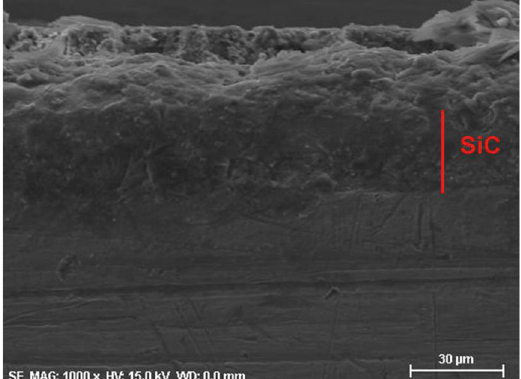
Figure 5 attests scratch